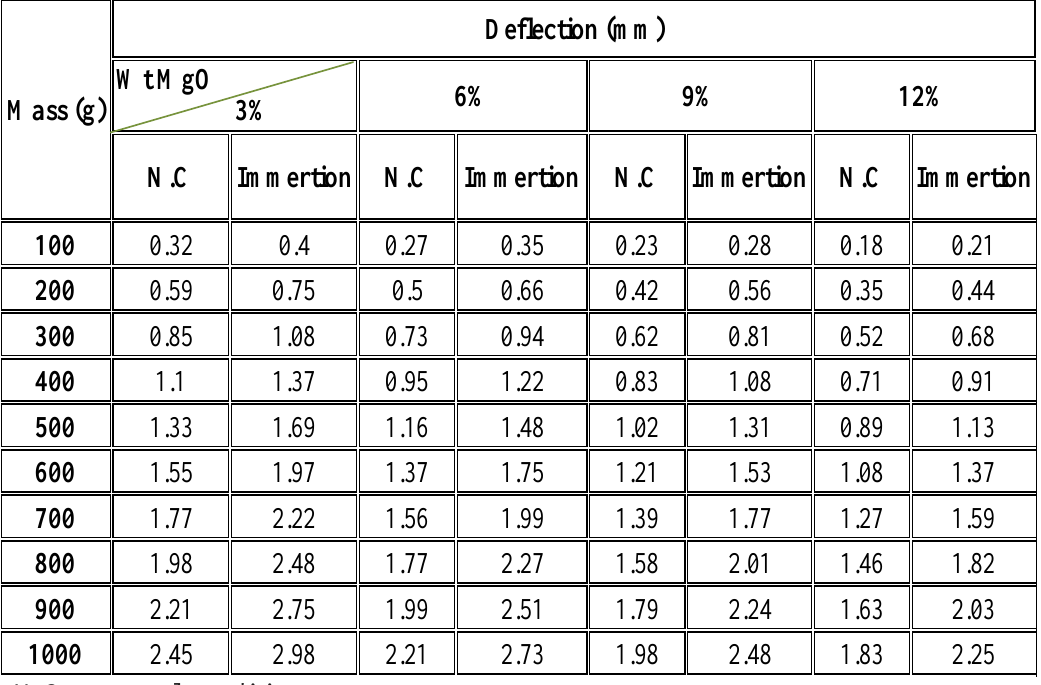
Table 1: Mass vairation with different concentrations of MgO in normal conditions and after immersion in H SO acid for 10 days . 2 4